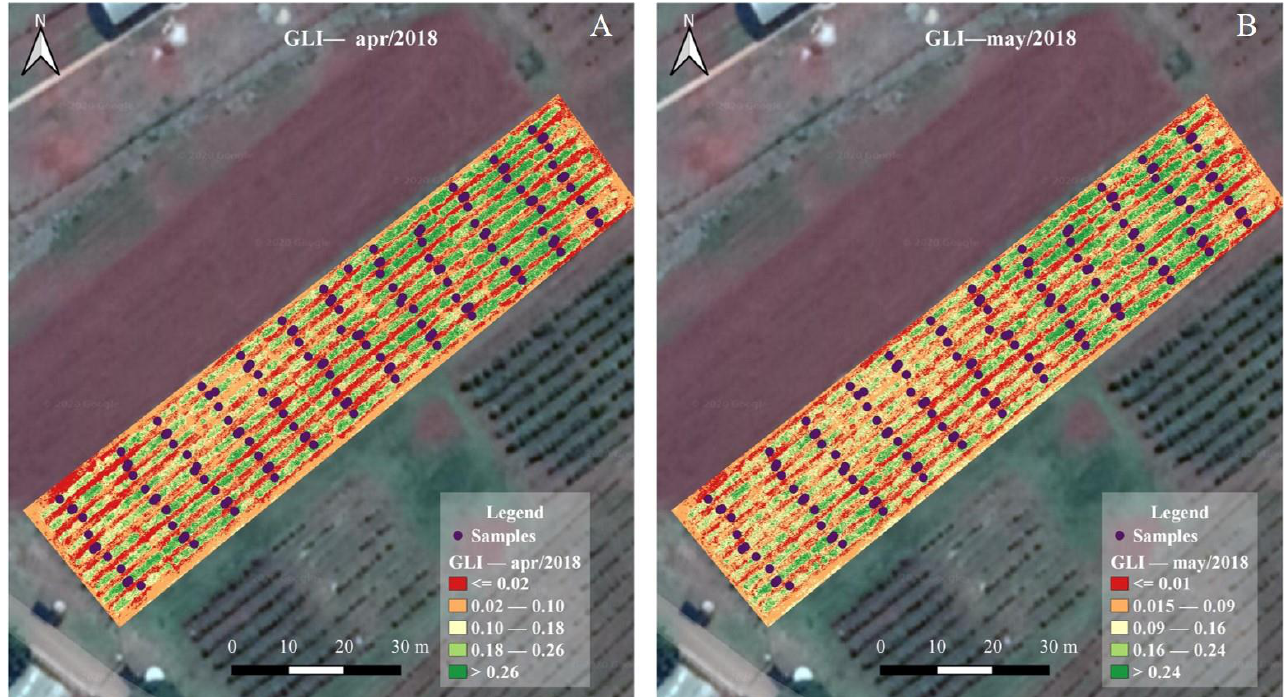
Figure 10. Fifth phase of the vegetative cycle of coffee evidenced by GLI: ( A )—GLI/april, ( B )—GLI/may.